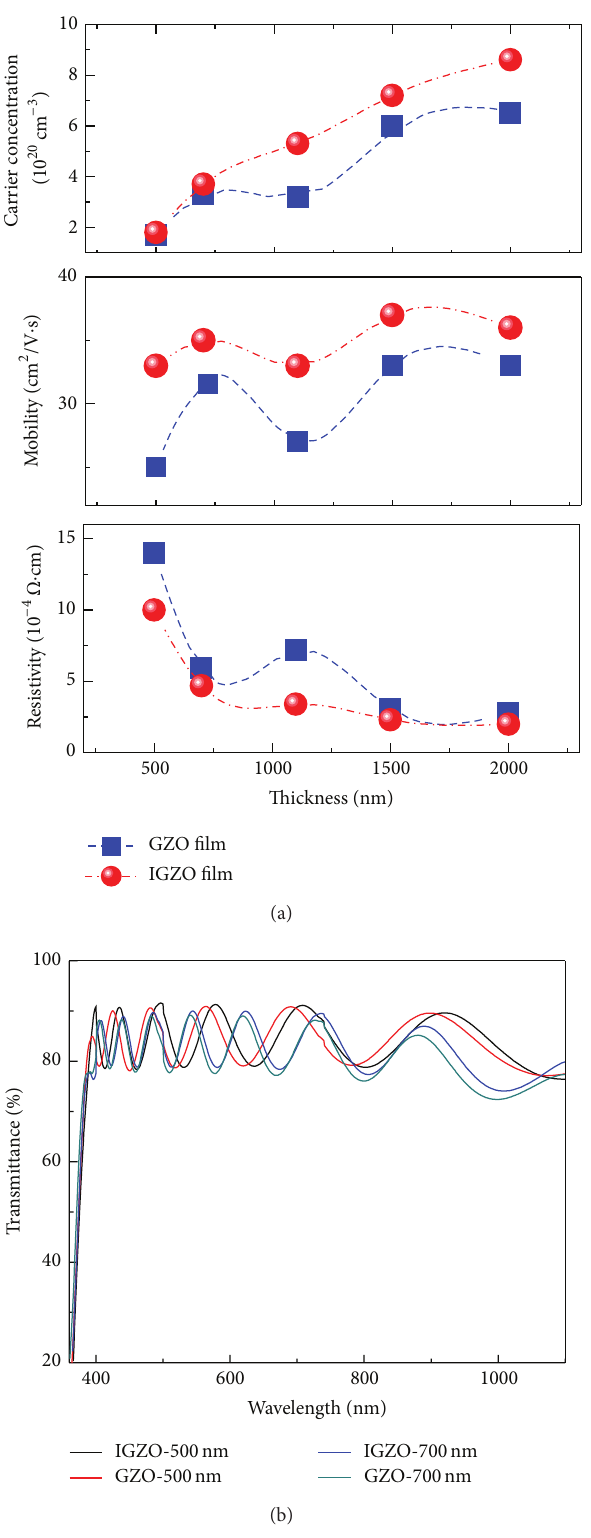
Figure 5: (a) Carrier concentration, mobility, and resistivity of postannealedGZO(Asample)andIGZO(Bsample)filmsatvarious film thicknesses from 500 to 2000 nm and (b) transmittance of postannealed GZO (A sample) and IGZO (B sample) films with two film thicknesses of 500nm and 700 nm for comparison.